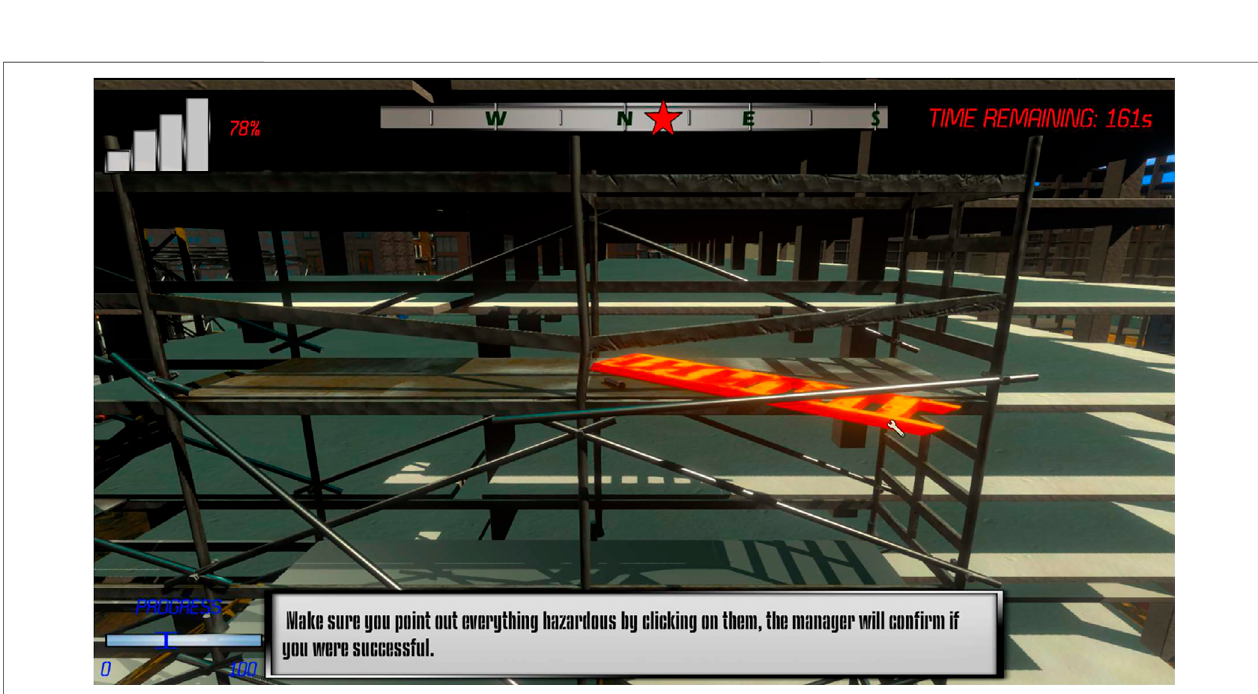
FIGURE 6 | Example of the hazard minigame. If a player spots a hazard using the drone they will be taken to a zoomed-in version of the hazard where they must click on all the hazards which will highlight red when clicked to signify and con fi rm it was a hazard.